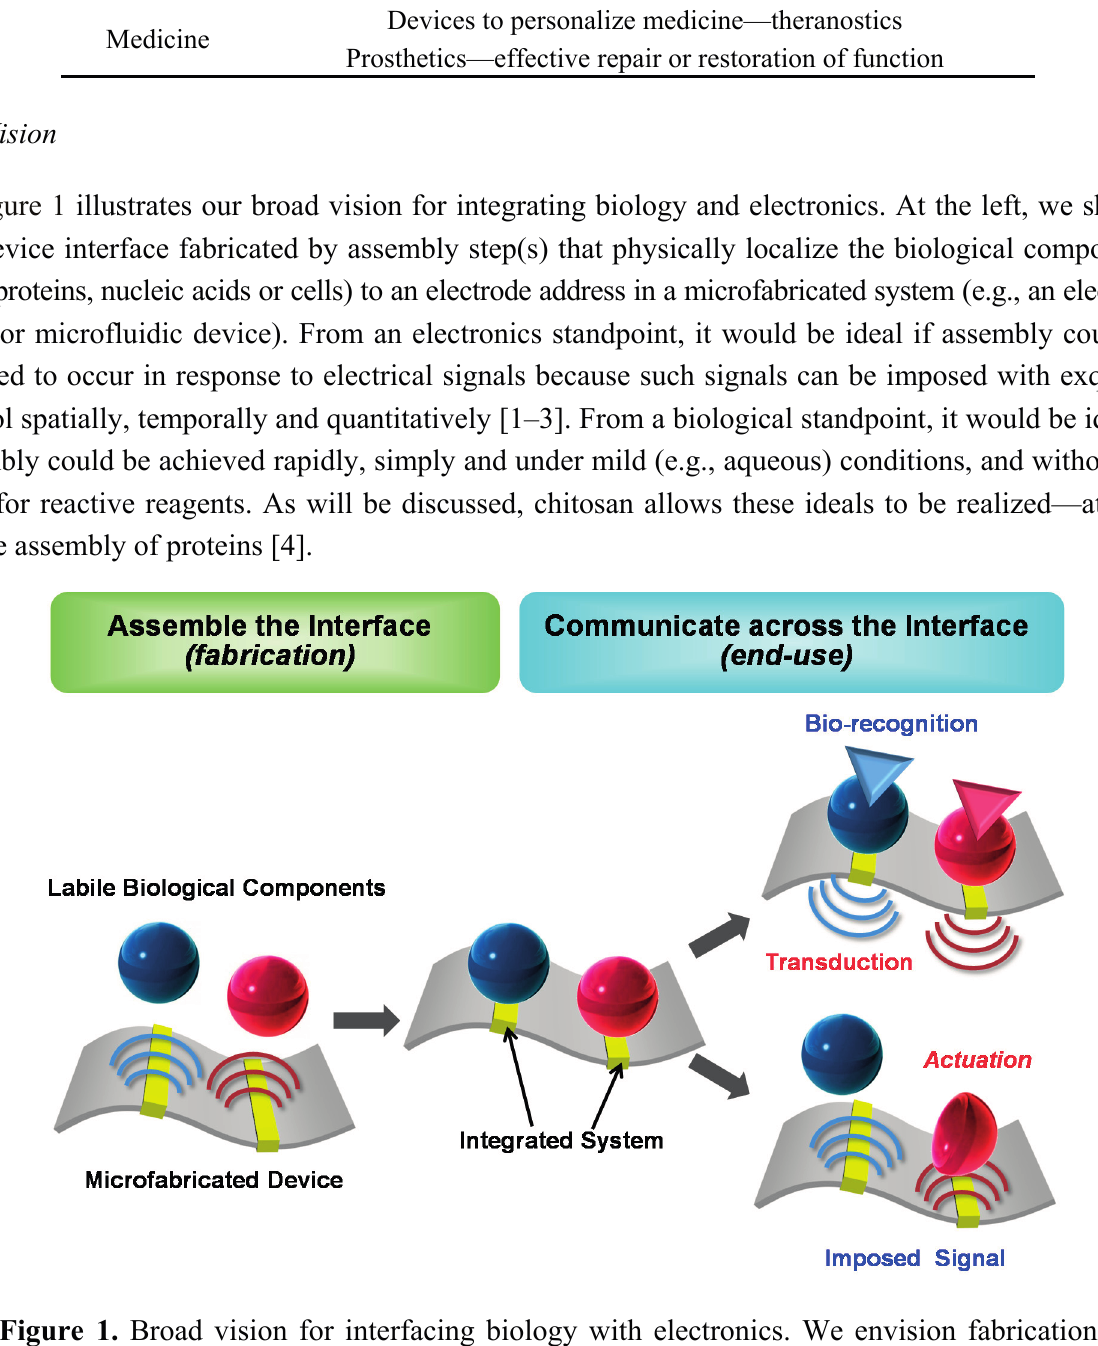
Figure 1. Broad vision for interfacing biology with electronics. We envision fabrication will enlist device imposed electrical signals to direct assembly of the bio-device